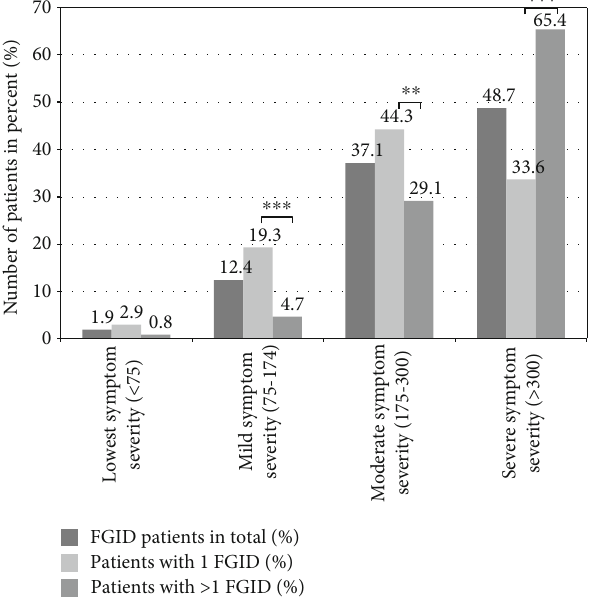
Figure 1: Di ff erences in GI symptom severity (IBS-SSS, range 0- 500) in FGID patients (total FGID patients (e ff ective n = 267 ) vs. patients with 1 FGID (e ff ective n = 140 ) vs. patients with > 1 FGID (e ff ective n = 127 )); ∗ p ≤ 0 : 05 ; ∗∗ p ≤ 0 : 01 ; ∗∗∗ p ≤ 0 : 001